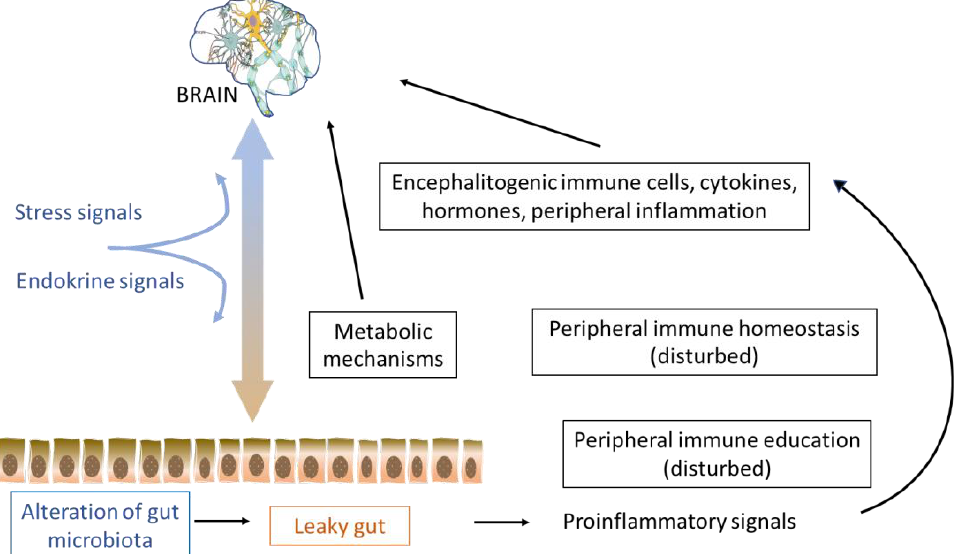
Figure 1. Schematics of the possible interaction between the gut and CNS via the immune system in multiple sclerosis.